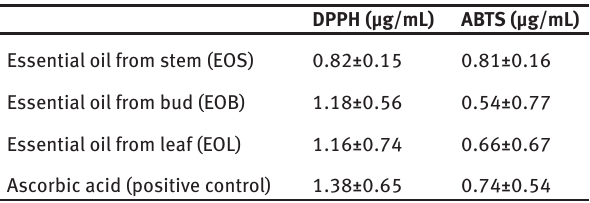
value free radical scavenging of essential Table 1: IC 50